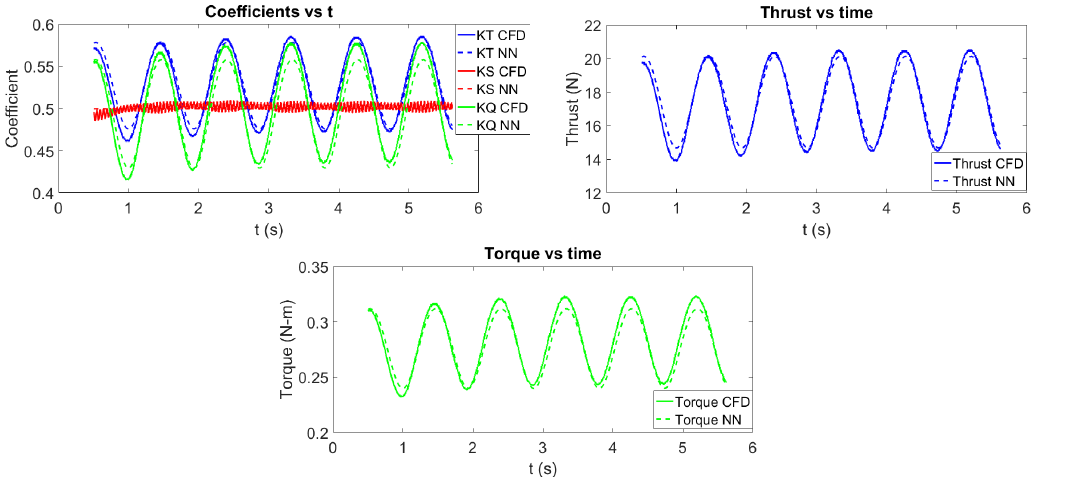
Figure 20. Behind condition coefficients, thrust, and torque for Test 2 as a function of time predicted by the neural network.